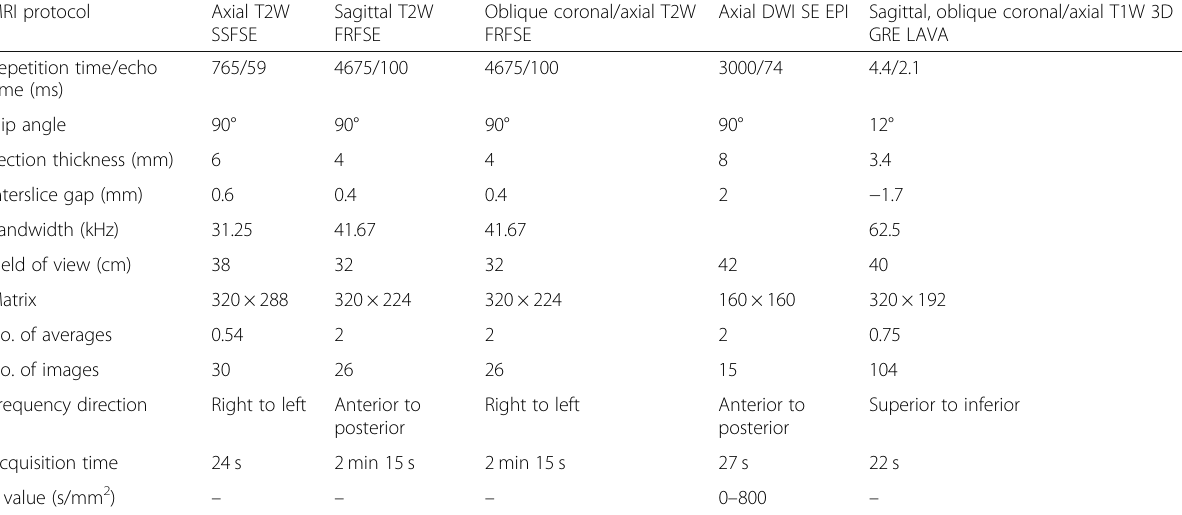
Table 2 Time-efficient noncontrast MRI protocol for urgent study of the female pelvis and non-cooperating patients MRI protocol Axial T2W